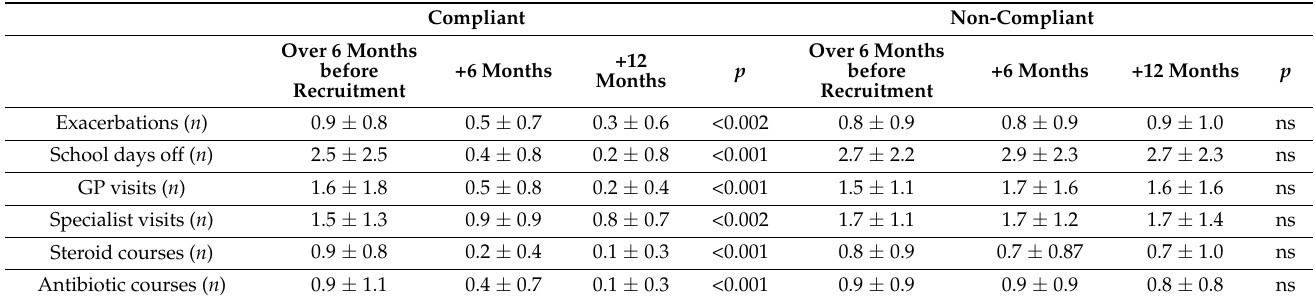
Table 3. Mean values (means ± sd) of health outcomes assessed over the six months before recruit- ment, and over 6 and 12 months of the study in compliant and non-compliant adolescents. Statistical comparisons (ANOVA) and corresponding levels of